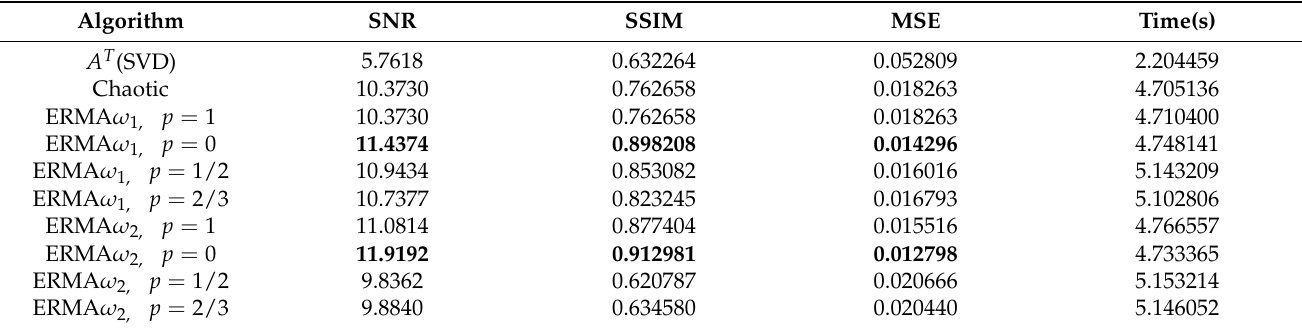
Table 4. The comparison of Figure 4 deblurring